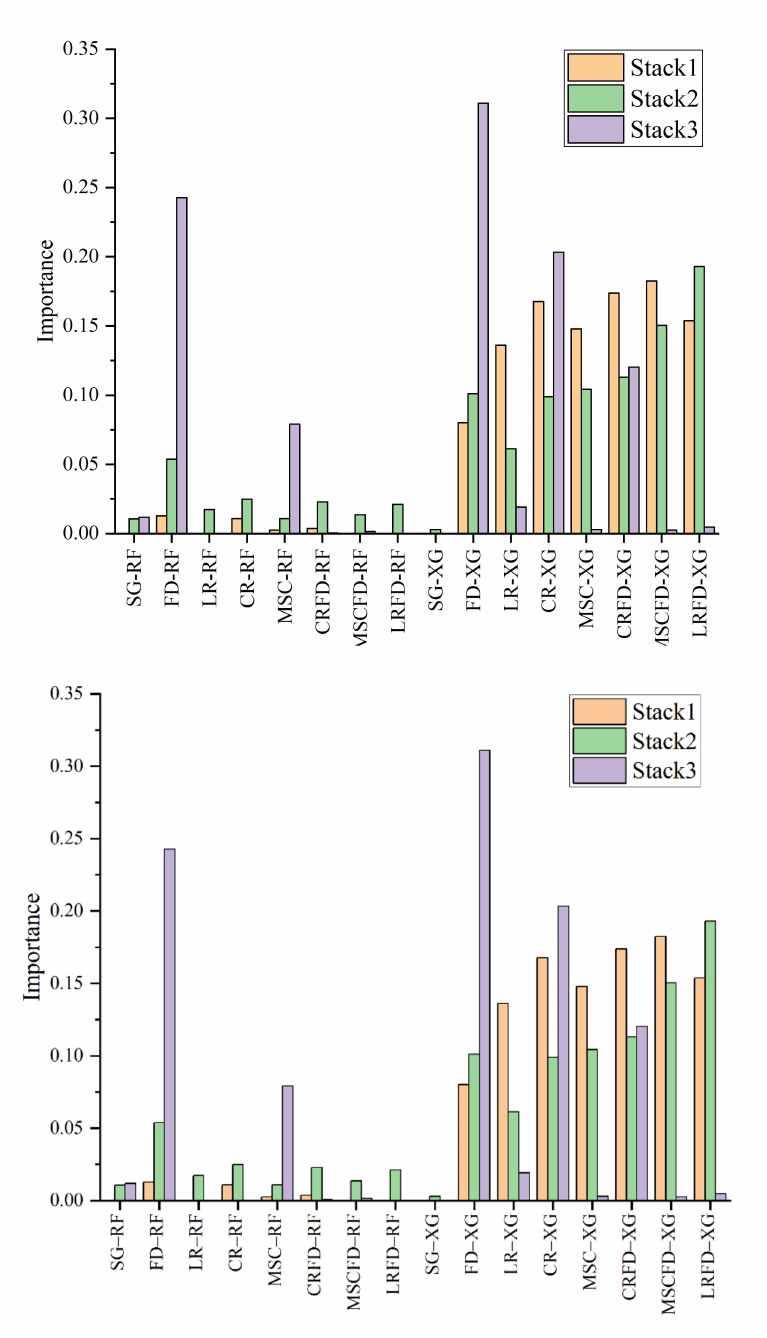
Figure 5. Feature importance of Stack1, Stack2, and Stack3 (Stacking models with SVR, RF, XG (i.e., XGBoost) and 16 pretreatment-models, respectively).